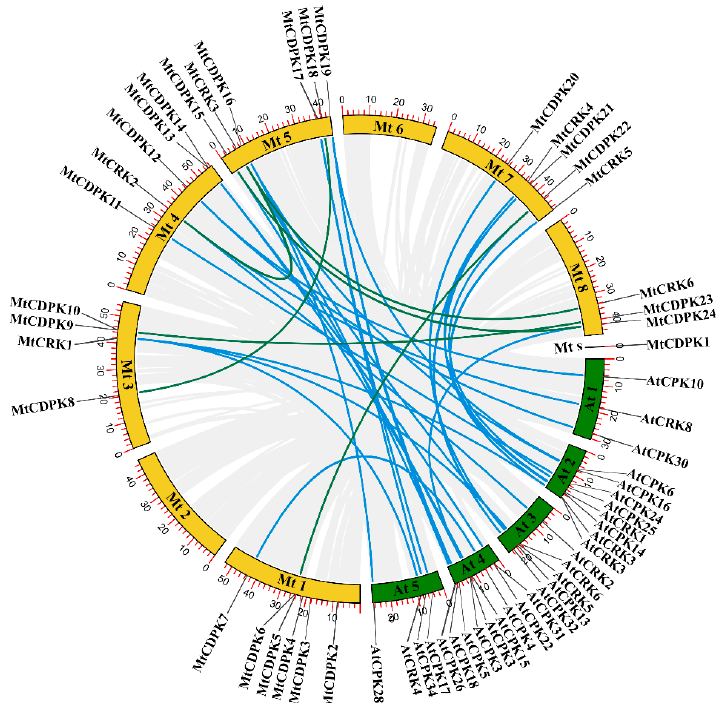
Figure 2. The collinear correlation of MtCDPKs and MtCRKs was displayed between M. truncatula and Arabidopsis genomes. The M. truncatula and Arabidopsis chromosomes were represented by yellow and green boxes, respectively. Collinear relationship of CDPKs and CRKs between M. truncatula and Arabidopsis indicated with blue lines, and within the M. truncatula genome indicated with green lines. s: M. truncatula scaffold0028. Table 2. Duplications of the CDPK and CRK genes in Medicago truncatula.